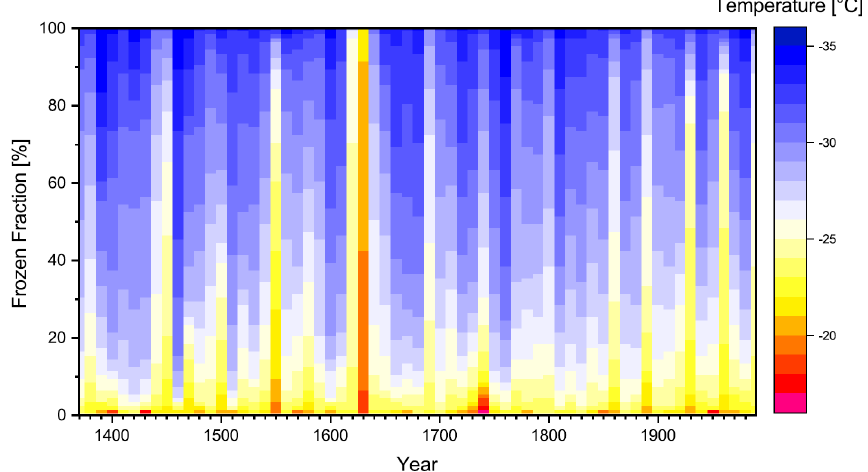
Figure 5. Frozen fractions of the samples with regular time intervals of 10 years depending on freezing temperature (colors). The temporal coverage of an individual sample typically averages over about 6